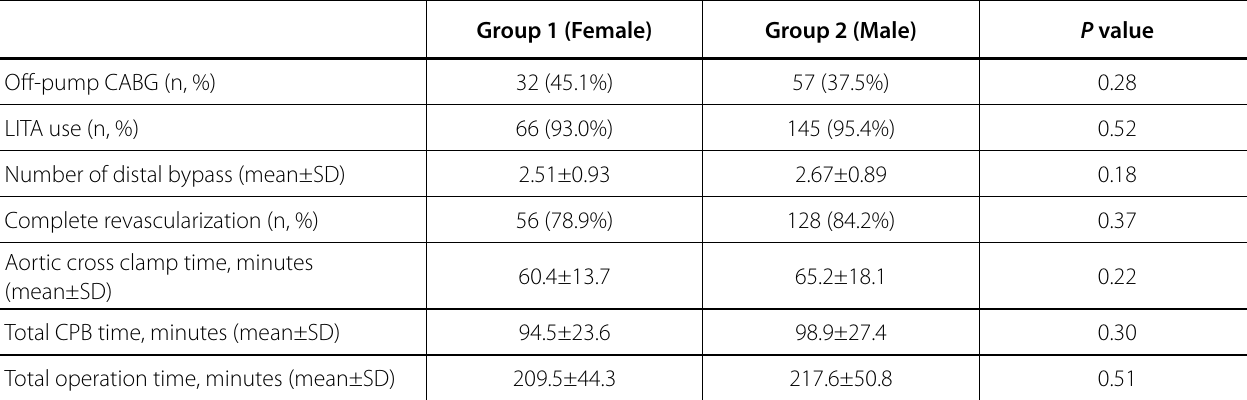
Table 2 . Intraoperative data of the